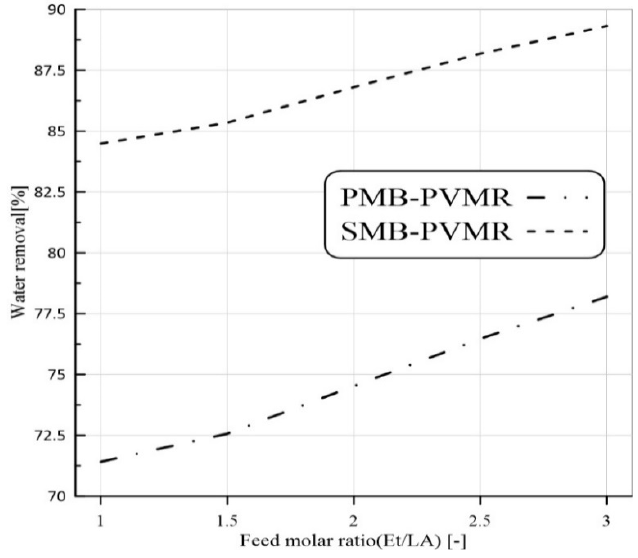
Figure 8. Comparison of water removal in MB-TR, PMB-PVMR, and SMB-PVMR based on variations in the feed molar ratio, Et/LA. Feed flow rate: 10 mm 3 /s, temperature: 333 K, and W = 8.6 g.